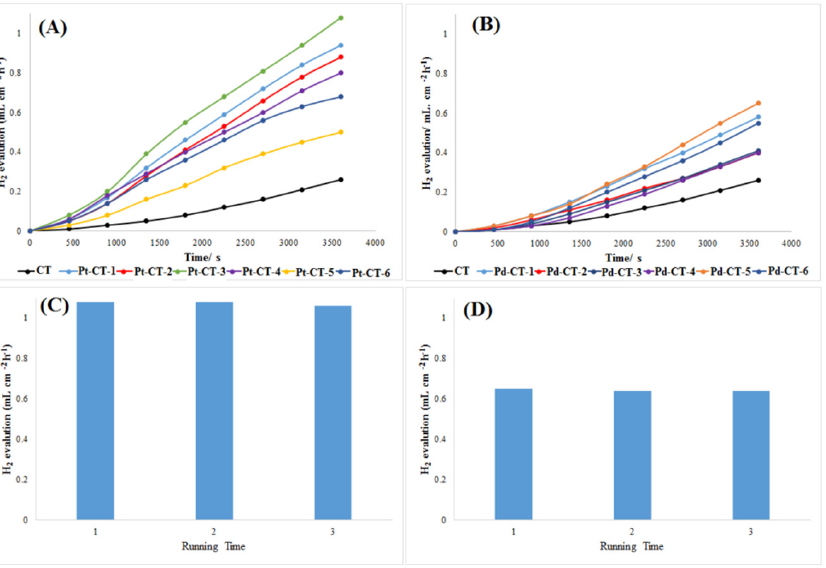
Figure 7. PEC water splitting and H2 generation of Pt-CT ( A ) and Pd-CT ( B ) samples during 1 h at 1.5 V vs. RHE in solution of KOH (1 M) with 5 vol% EG, reusability investigation of the Pt-CT-3 ( C )